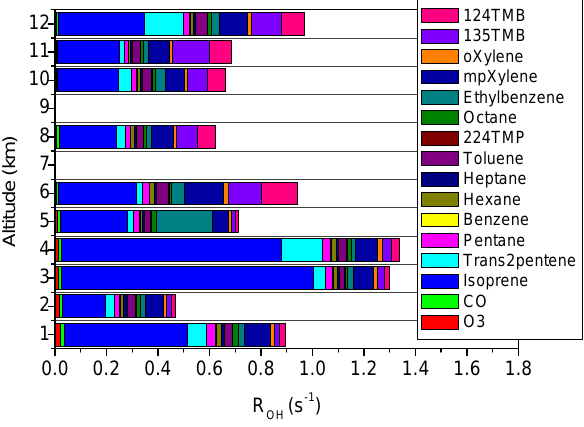
Fig. 9. Vertical profiles of O 3 , CO and NMHC contribution to total Fig. 9: Vertical profiles of O 3 , CO and NMHC contribution to total reactivity R OH reactivity R OH . Average are calculated at altitudes ranges of 0– Average are calculated at altitudes ranges of 0-1 km (54 data points), 1-2 km (18 data points), 1km (54 data points), 1–2km (18 data points), 2–3km (13 data 2-3 km (13 data points), 3-4 km (9 data points), 4-5 km (5 data points), 5-6 km (3 data points), 3–4km (9 data points), 4–5km (5 data points), 5–6km (3 points), 7-8 km (6 data points), 9-10 km (12 data points), 10-11 km (5 data points), 11-12 km (22 data points) data points), 7–8km (6 data points), 9–10km (12 data points), 10– 11km (5 data points), 11–12km (22 data